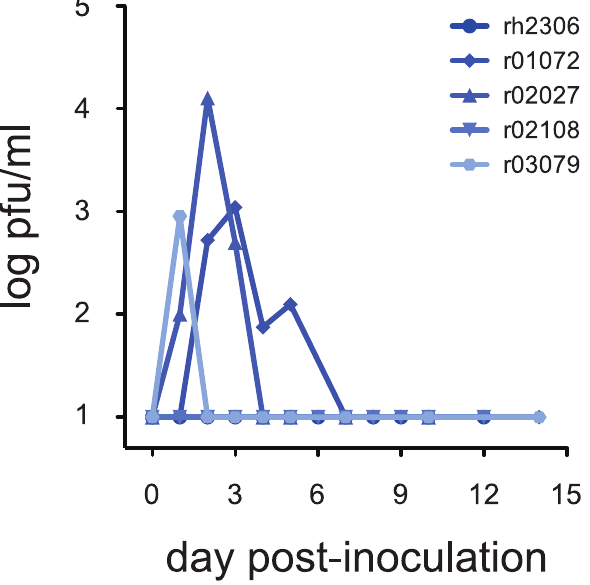
Figure 1. A seasonal human influenza virus replicates in rhesus macaques. Five rhesus macaques were inoculated with 9 million plaque-forming units (pfu) influenza virus A/Kawasaki/173/2001 (K173, H1N1) by a combination of routes as described in the text. Animals had no detectable antibodies against K173 at the time of inoculation. Virus replication in nasal secretions was monitored using standard plaque assays. Virus titer is expressed as pfu/ml nasal swab fluid.